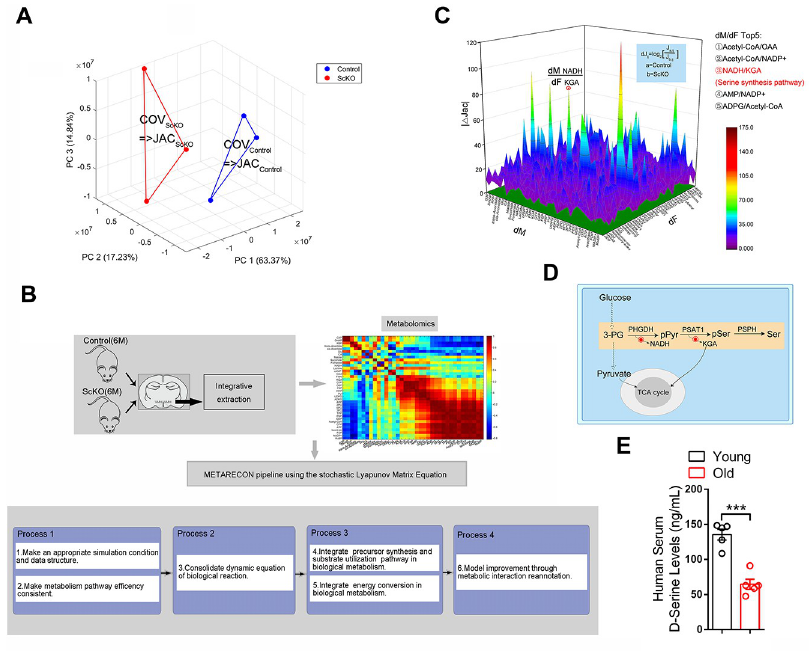
Fig 3. Menin deficiency results in disrupted metabolism in the hypothalamus. (A) PCA of the metabolomics data revealing an obvious separation between the hypothalamus of 13-month-old ScKO mice and control mice. (B) For inverse modeling of biochemical regulation from metabolomics covariance data, a metabolic reconstruction and pathway reduction from metabonomics is performed (RECON). The metabolite variance of 2 groups is visible, which is further exploited for the calculation of the Covariance matrix (COV) and subsequently for the Jacobian matrix (JAC) using the stochastic Lyapunov matrix Eq 1 (see the METARECON strategy in Materials and methods). (C) Differential Jacobian matrix of the hypothalamus of 13-month-old ScKO mice and control mice derived from covariance data from the metabolomics datasets. All entries represent median values of 10 3 calculations normalized to the square of interquartile distance. dF and dM characterize the entries of the Jacobian matrix and refer to Eq 2 (see the METARECON strategy in Materials and methods). The greatest perturbation was identified as the Jacobian entry ðf NADH = ðf KGA , pointing to D-serine synthesis pathway in the underlying biochemical network in panel D. (D) Simplified biochemical interaction network of D-serine synthesis pathway adjusted to the measured metabolites. (E) D-serine levels in serum from young (22-26Y) and old individuals (83-94Y) were determined by ELISA; n = 5. Data represent mean ± SEM, n.s.: not significant, � p < 0.05, �� p < 0.01, ��� p < 0.001. Statistical applications were analyzed by one-way ANOVA with Tukey’s post hoc analysis. The underlying data of Fig 3 can be found in S3 Information. PCA, principal component